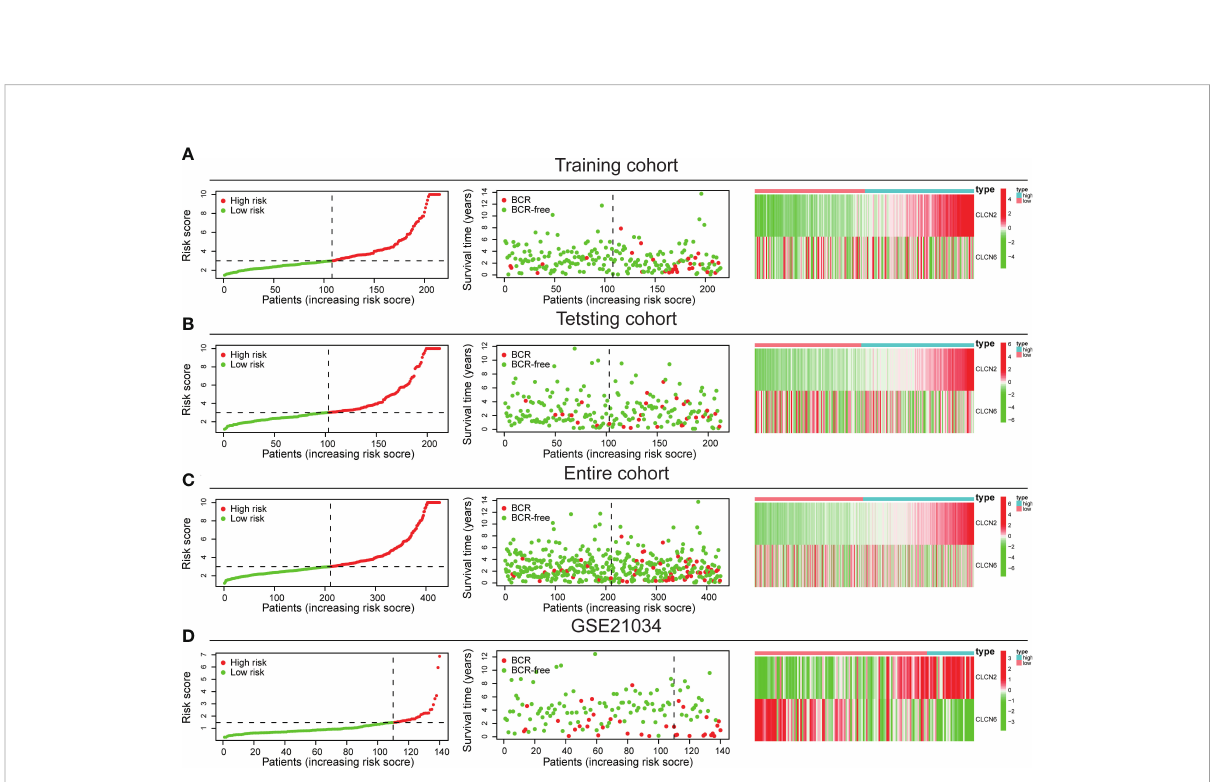
FIGURE 4 Internal and external validation of the signature. The distribution of risk scores, survival status, and heatmap in (A) the training TCGA-PRAD, (B) the testing TCGA-PRAD, (C) entire TCGA-PRAD, and (D) GSE21034